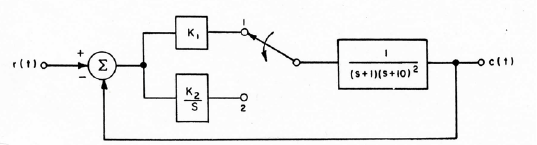
Figure 3. The dual-mode model used by Mantgiaris to achieve both rapid and accurate step responses by a second-order plant. From